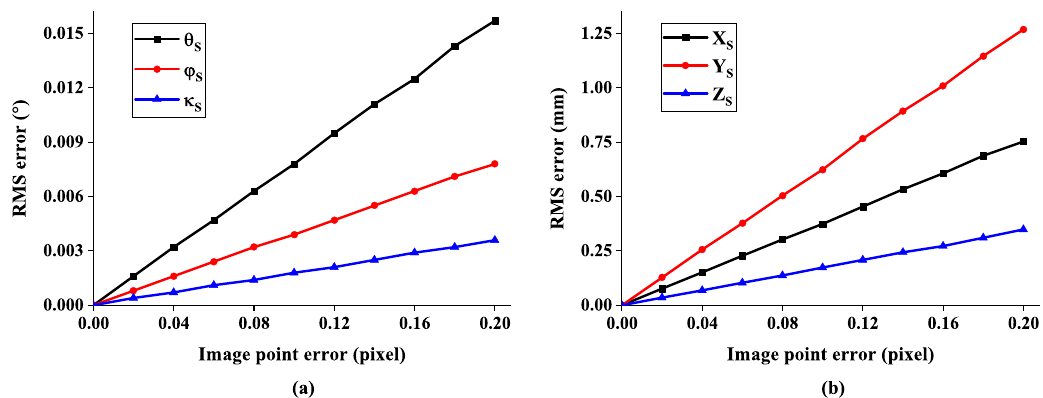
Figure 10. The RMS error of 6-DOF with respect to image point error: ( a ) the error of rotation angle and ( b ) the error of system